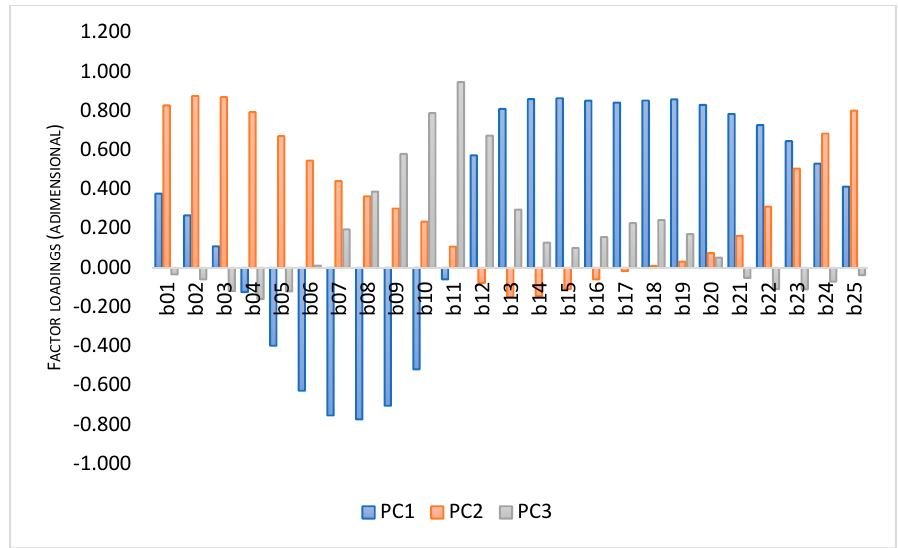
Figure 5. Histogram of the Principal Component Analysis (PCA) factor loadings of the NDVI temporal bands over the first three PC axis (year 2019 as an example).